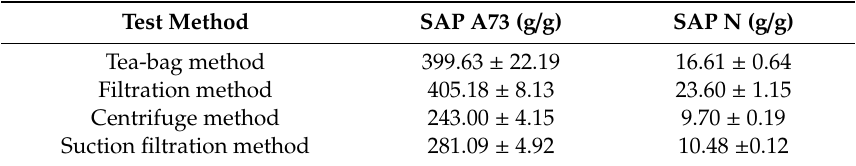
Figure 3. Development of SAP absorption in deionized water measured with di ff erent methods: ( a ) anionic SAP A73 and ( b ) AM-based SAP N. Table 2. Final absorption at 24 h in deionized